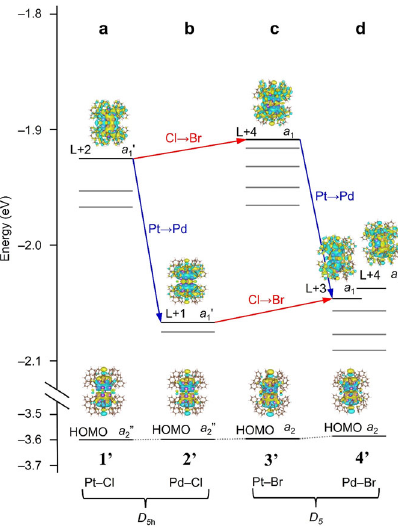
Fig. 5 Orbital energies and Kohn – Sham orbital diagram related to the fi rst peak in the optical absorption spectrum. a , b , c , and d are Kohn – Sham orbital diagram of 1 ’ , 2 ’ , 3 ’ , and 4 ’ , respectively. The transition dipole moment from HOMO to LUMO becomes zero. This is the reason why the HOMO − LUMO transition is forbidden for 1 − 4 .